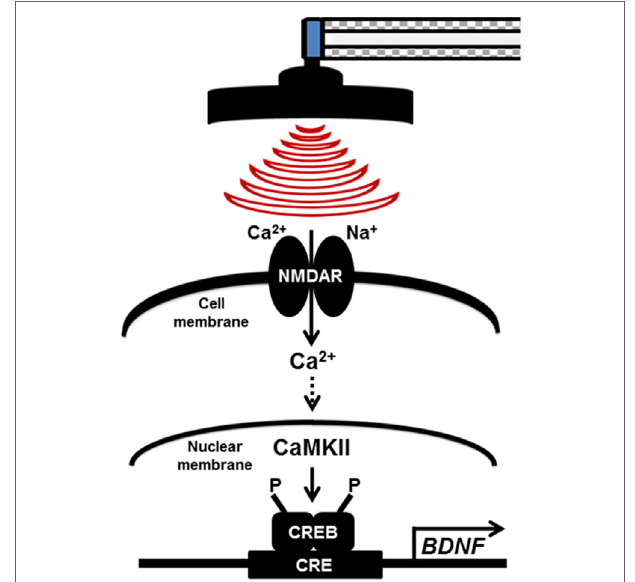
FigUre 6 | Potential therapeutic mechanisms for high-frequency repetitive magnetic stimulation (rMS) in both undifferentiated and differentiated Neuro-2a cells. The long-term potentiation pathway was confirmed to be an enriched relevant Kyoto Encyclopedia of Genes and Genomes pathway in high-frequency rMS stimulation in both undifferentiated and differentiated Neuro-2a cells. In addition, high-frequency rMS can activate the Ca 2 + – calmodulin-dependent protein kinase II (CaMKII)–cAMP-response element- binding protein (CREB) signaling pathway. In addition, phospho-CREB and brain-derived neurotrophic factor (BDNF) expression was increased via activation of the Ca 2 + –CaMKII–CREB signaling pathway in both undifferentiated and differentiated Neuro-2a cells. NMDAR, N-methyl-d- aspartate receptors; CaMKII, Ca 2 + –calmodulin-dependent protein kinase II; CREB, cAMP-response element-binding protein; CRE, cAMP-response element; BDNF, brain-derived neurotrophic